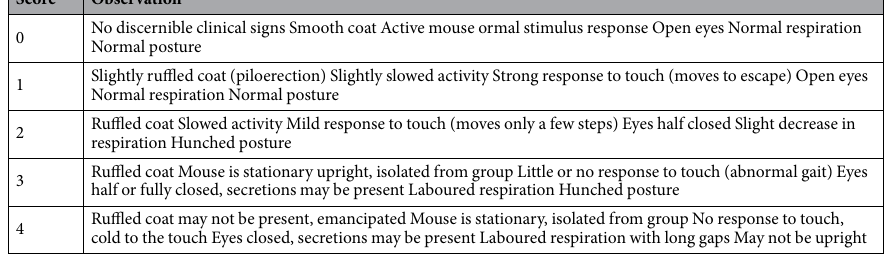
Table 1. Sepsis severity score.